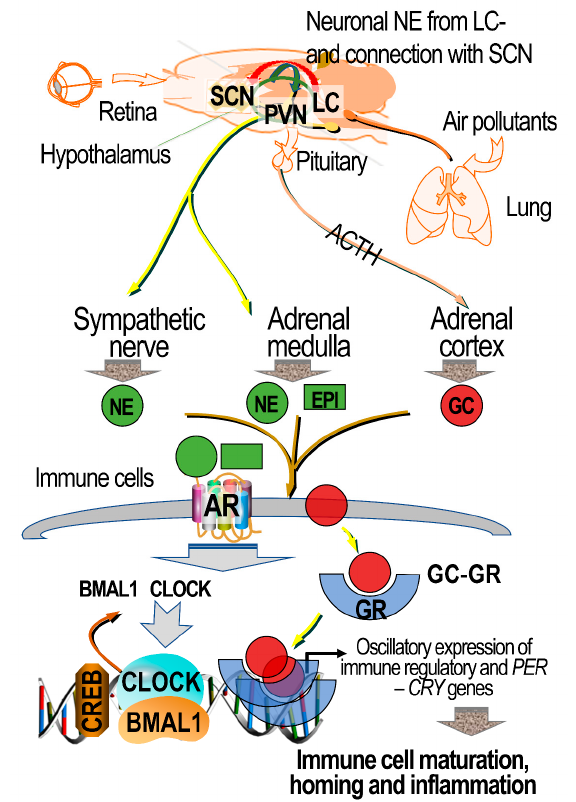
Figure 4. Proposed schematic of how adrenergic and glucocorticoid mechanisms regulate circadian changes and environmental stress signals to direct immune responses with oscillatory patterns. The suprachiasmatic nucleus (SCN), receiving photonic signals from the retina via the retinohypotha- lamic tract, transmits these to the paraventricular nucleus (PVN) of the hypothalamus, which also integrates other stress signals from afferent autonomic sensory nerves, including those induced by pulmonary encountered air-pollution-induced stress. These signals are integrated in the hypotha- lamus and relayed to the periphery through: (1) sympathetic nerves, which transmit signals to the peripheral organs by releasing norepinephrine (NE); (2) sympathetic nerves innervating the adrenal medulla and regulating the production and release of epinephrine (EPI) and norepinephrine into circulation; and (3) the hypothalamus–pituitary–adrenal (HPA) axis mediating the pituitary release of adrenocorticotropic hormone (ACTH), and then stimulating glucocorticoid (GC) production by the adrenal cortex. Adrenal glucocorticoids locally regulate the release of medullary hormones. Catecholamines and glucocorticoids released into circulation induce pulsatile cellular physiological changes resulting from stress and circadian rhythms through binding to their receptors—AR and GR subtypes, respectively. Within the central nervous system, the locus coeruleus (LC) produces norepinephrine, which is transmitted across many brain regions, including the SCN, and can regu- late circadian changes centrally. Circulating catecholamines and glucocorticoids bind to ARs and GRs in diverse organs and cells, including immune cells, to regulate the expression of the circadian locomotor output cycles kaput (CLOCK) and brain and muscle aryl hydrocarbon receptor nuclear translocator-like 1 (BMAL1) regulated genes. The signaling involves the activation of transcription factors, including the cyclic AMP response element-binding protein (CREB), to modulate the ex- pression of CLOCK and BMAL1-regulated genes. The CLOCK and BMAL1 transcription factors regulate the transcription of genes encoding circadian proteins, such as period circadian proteins (PERs) and cryptochromes (CRY). The rhythmic activation of GRs upon binding to GCs, and their nuclear translocation, can modulate gene expression for inflammatory processes in association with CLOCK and BLAM1 in immune cells that facilitate diurnal changes in maturation and homing of immune cells and